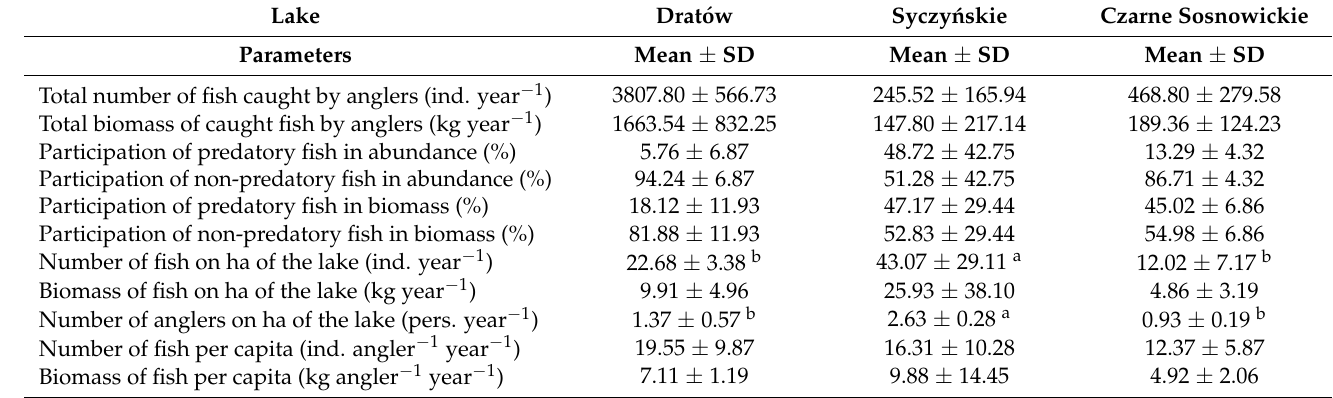
Table 3. The data on the angling use of the studied lakes in the years